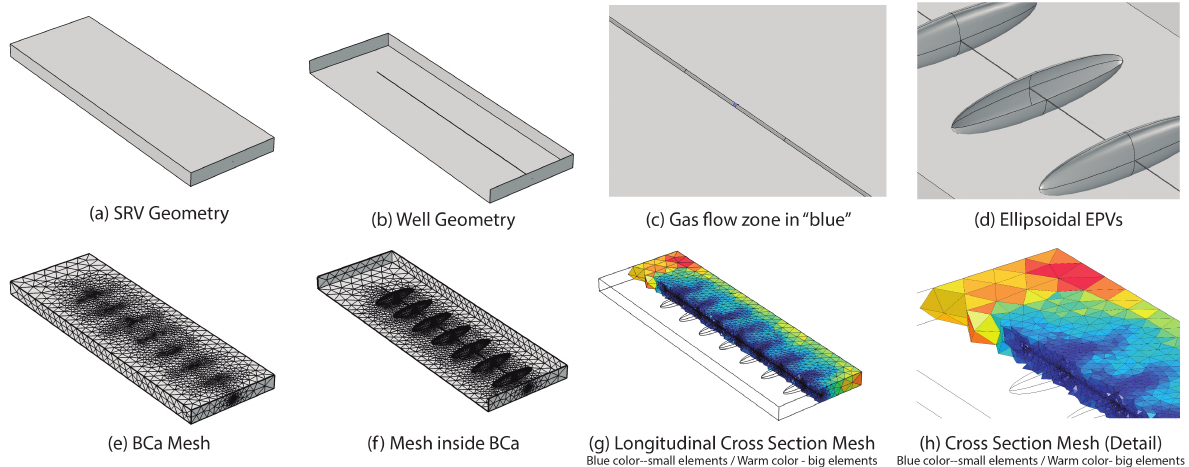
Figure 3. Schematic representation of the workflow of the numerical modeling process, ( a – h